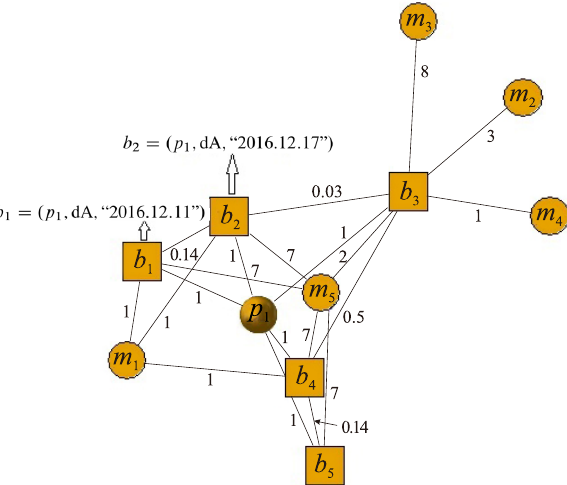
Fig. 1 Example of health-seeking temporal graph of patient p . The spherical node indicates a patient with a chronic 1 disease, each square node represents a health-seeking behavior, and each circular node is a